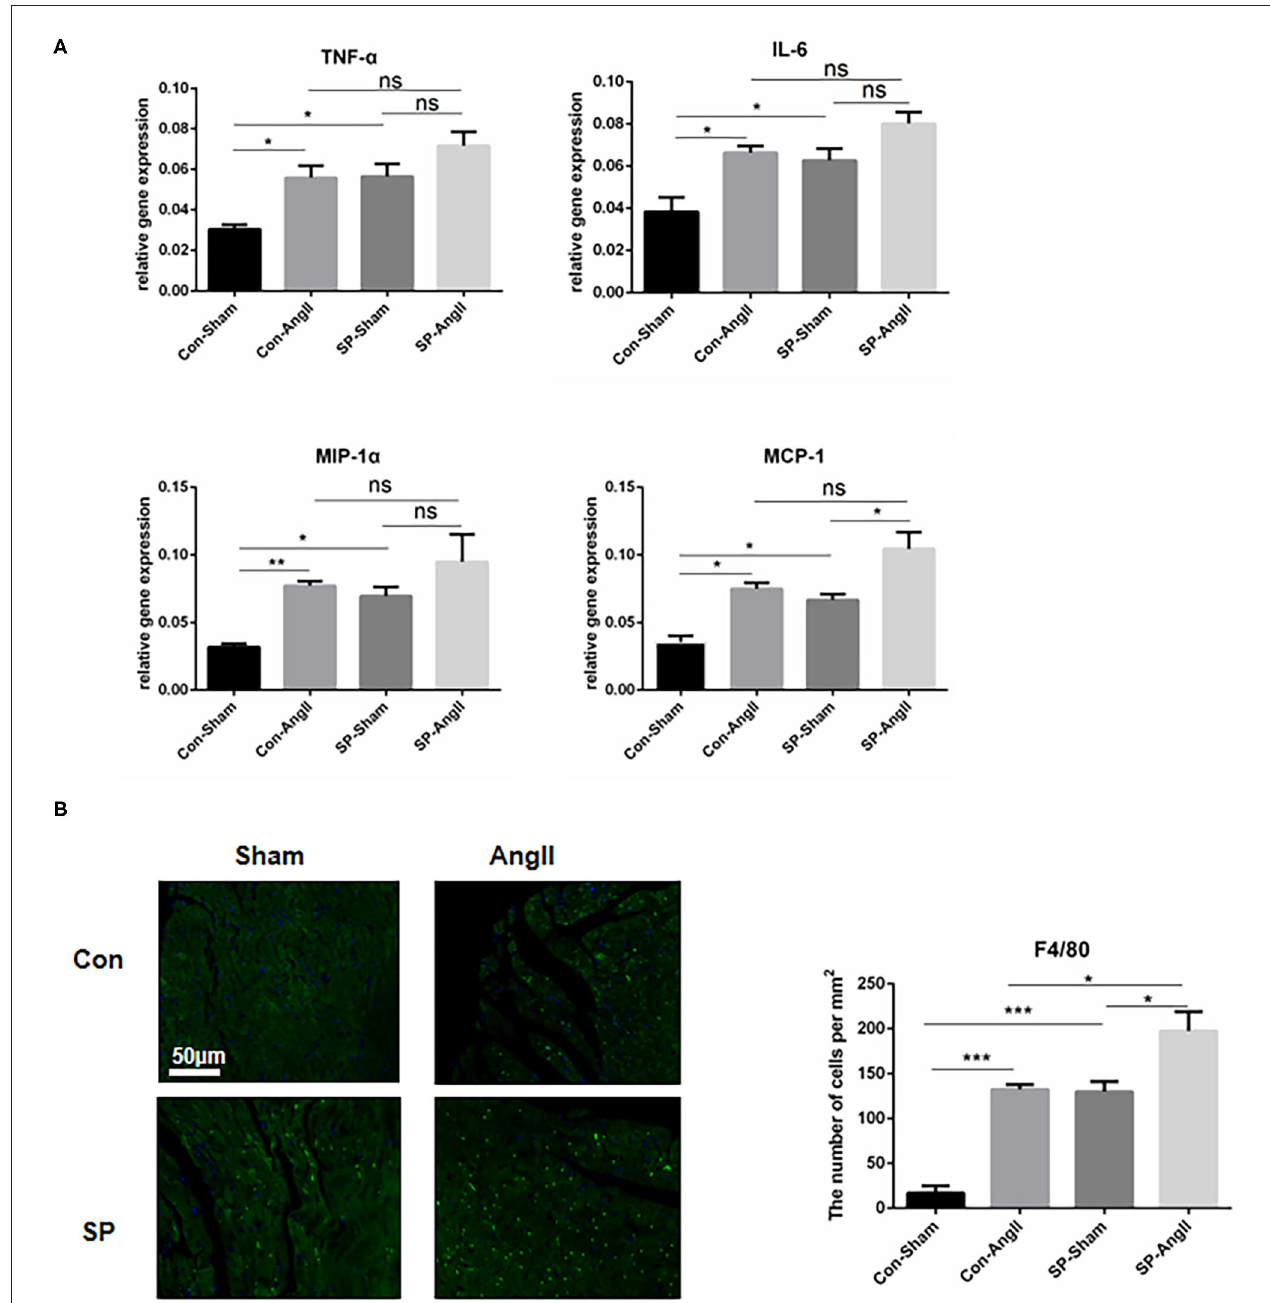
FIGURE 4 | Cardiac fibroblast-specific PGC-1 α KO aggravates the inflammatory response in the heart. (A) qPCR analysis of the mRNA expression levels of inflammatory genes ( TNF- α , IL-6 , MCP-1 , MIP-1 α ). N.S. indicates no significant difference. (B) Representative cross sections of the heart stained for F4/80 and quantitative analysis of the number of positive cells. * p < 0.05, ** p < 0.01, *** p < 0.001. Data represent mean ± SEM ( n = 5 per group).